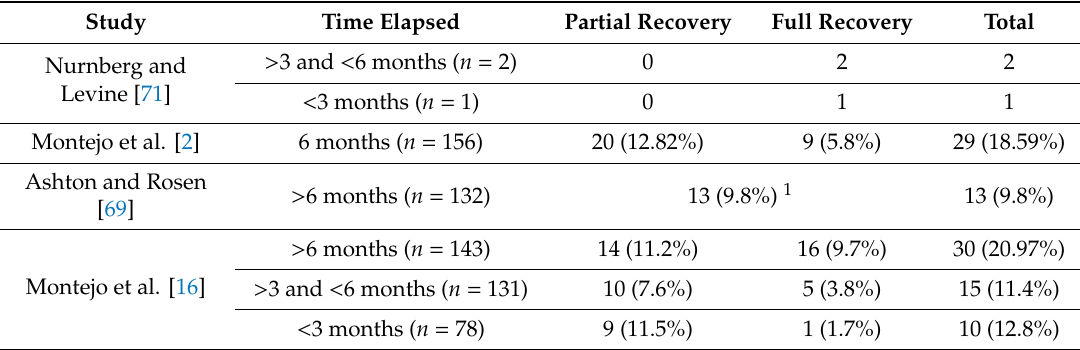
Table 2. Rates of spontaneous remission of treatment emergent sexual dysfunction (TESD) [2,16,71–73]. Study Time Elapsed Partial Recovery Full Recovery